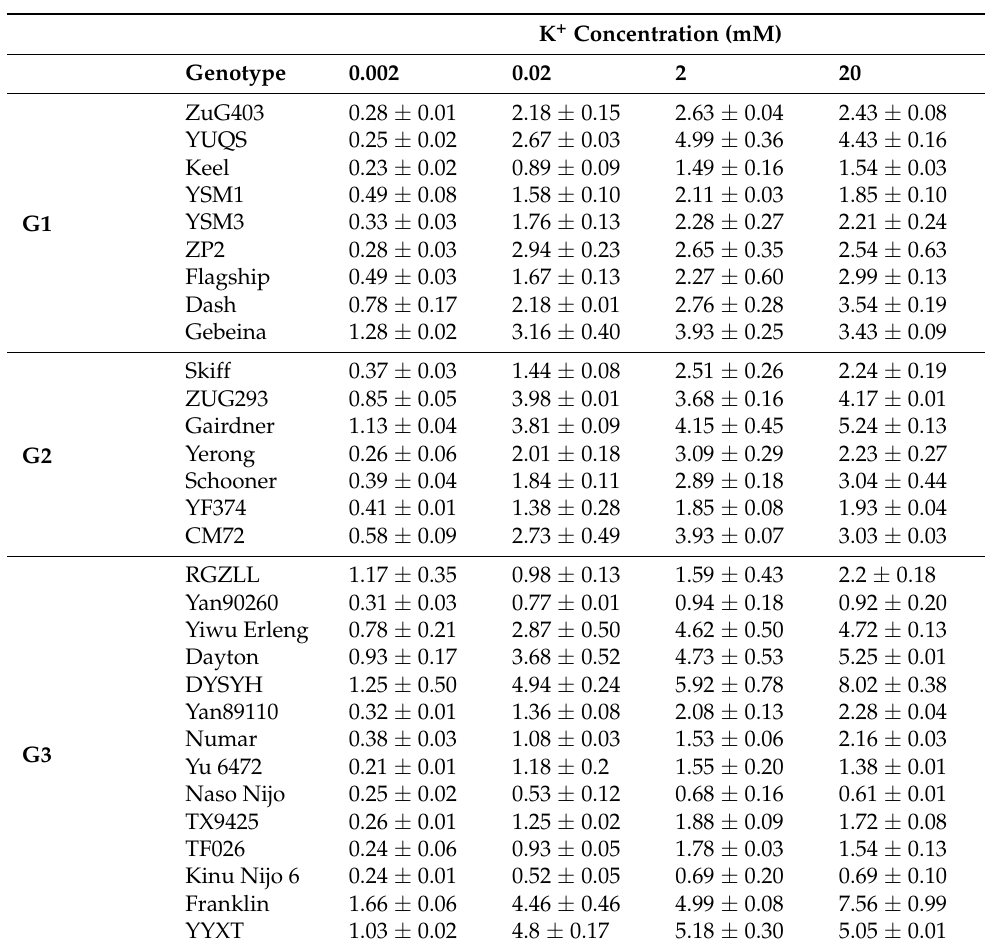
Table 3. Genotypic variation in the shoot dry weight g/plant of barley genotypes under different concentration of K + supply. Values are mean ± SE ( n = 6) and G represents different groups of genotypes. Genotypes have been divided into three group G1, G2 and G3 according to cluster analysis (see Section 3.1 and Figure